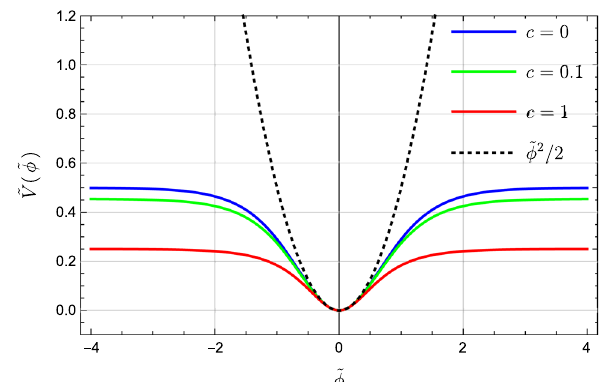
Fig. 1 The plot shows the potential shape of the α attractor type poten- tial (3) for different values of c